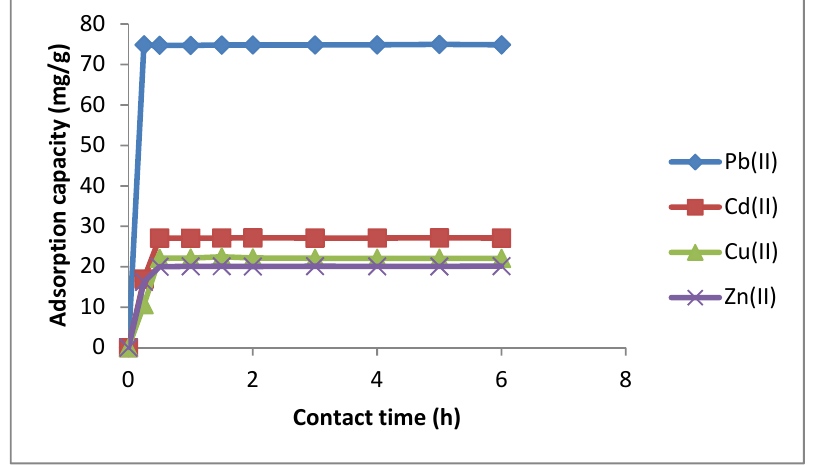
Figure 7. Effect of pH value on the retention of Pb(II), Cd(II), Cu(II) and Zn(II) on